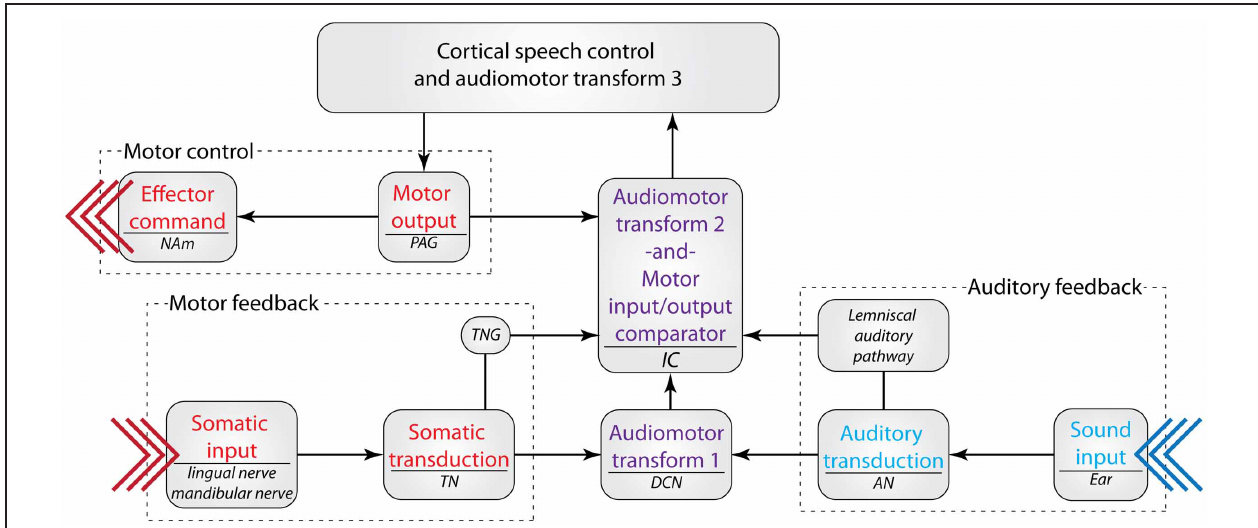
vocalization in order to achieve a desired auditory structure [presumably determined by cortical planning regions; see Hickok (2012)]. If the motor error = 0, self-generated vocalization reafference is cancelled out (Tammer et al., 2004) and no adjustment is necessary; if the motor error (cid:5)= 0, the corresponding audiomotor error is sent to cortical control regions for further analysis and correction. The potential role of the DCN in this circuit is currently unknown, but may be associated with monitoring audiomotor feedback of non-vocalization signals. See Table 1 for